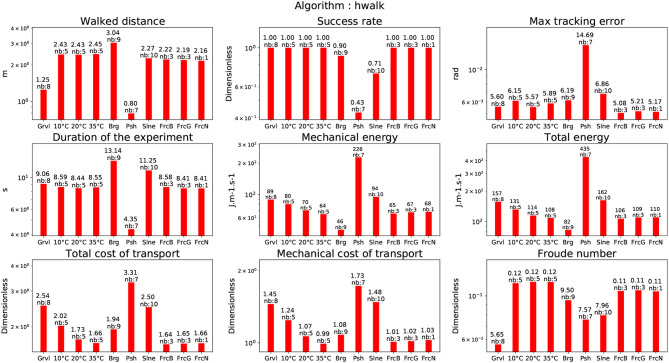
Straight walk with Kajita's walking pattern generator (Kajita et al., 2003a).